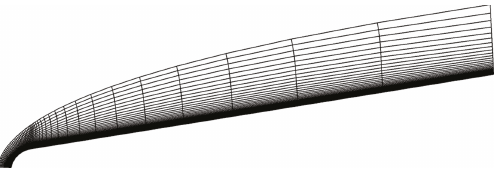
Figure 4: R3 model, mesh size